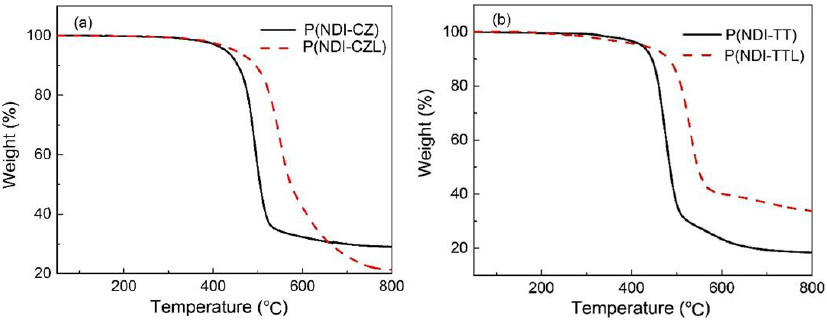
Figure 2. The thermogravimetric analysis (TGA) traces of the polymers. ( a ) for P(NDI-CZ), P(NDI-CZL) and ( b ) for P(NDI-TT), P(NDI-TTL).